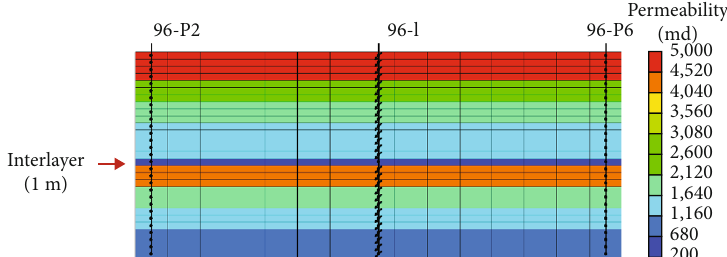
Figure 4: Numerical simulation model built to simulate the steam fl ooding process in the J